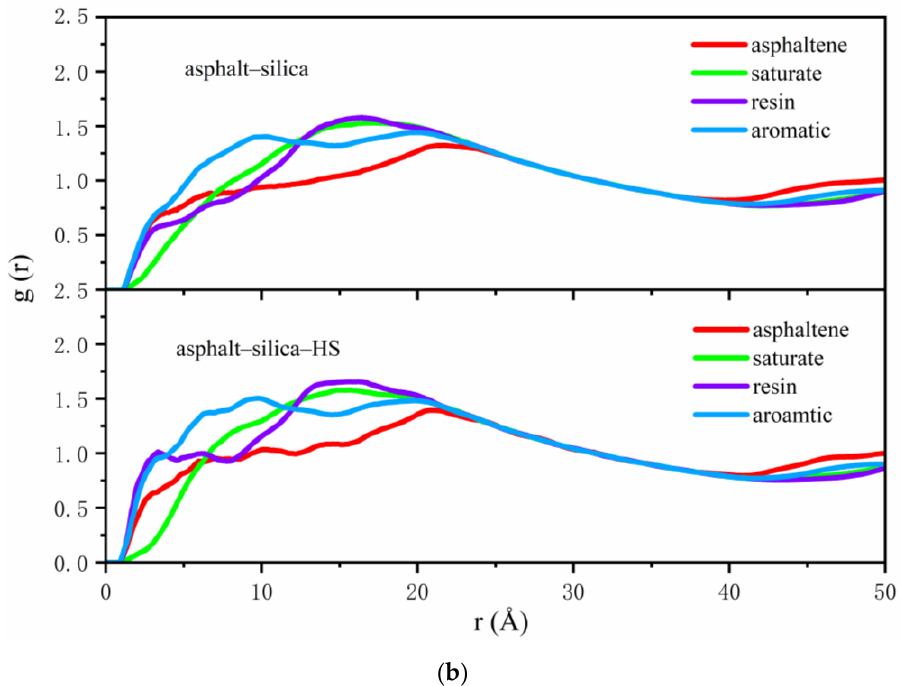
Figure 6. Asphalt–aggregate interface radial distribution function (RDF) curves with and without adsorbed water on the aggregate surface: ( a ) asphalt–calcite and ( b ) asphalt–silica.